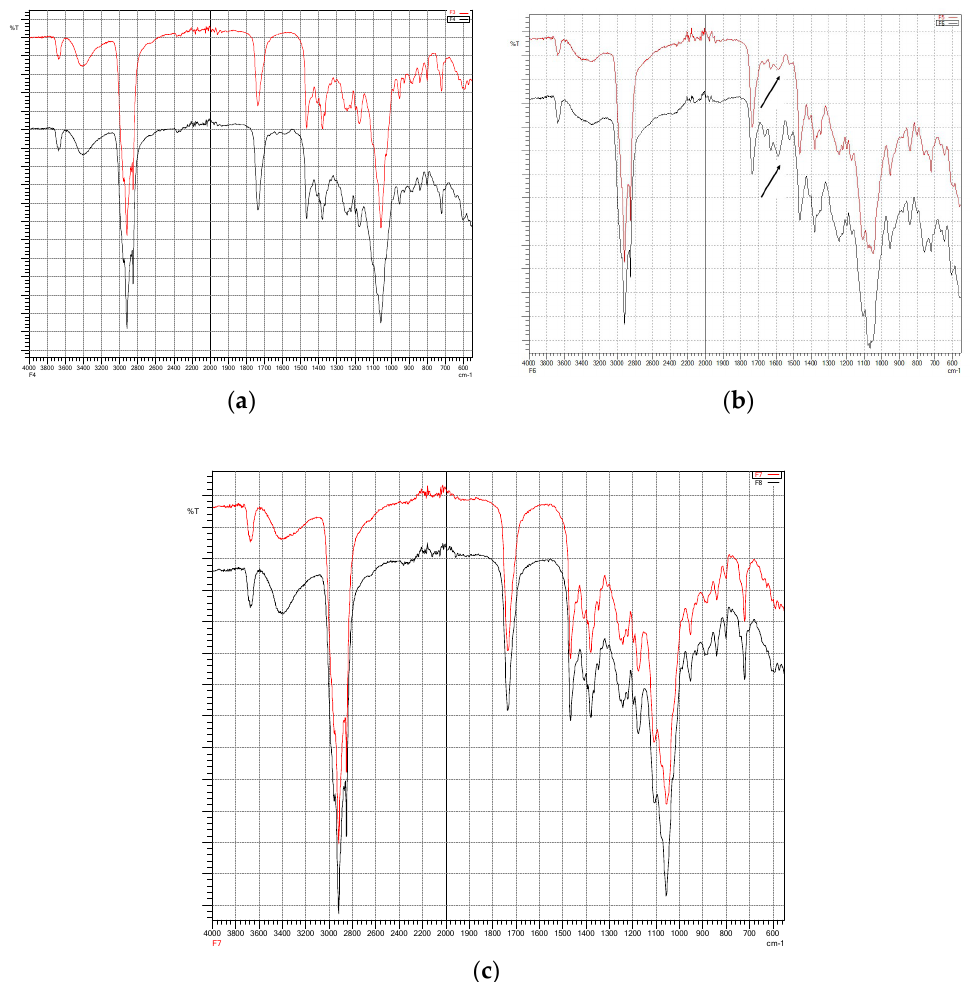
Figure 6. FTIR spectra for ( a ) formulations 3 and 4; ( b ) formulations 5 and 6; ( c ) formulations 7 and 8.